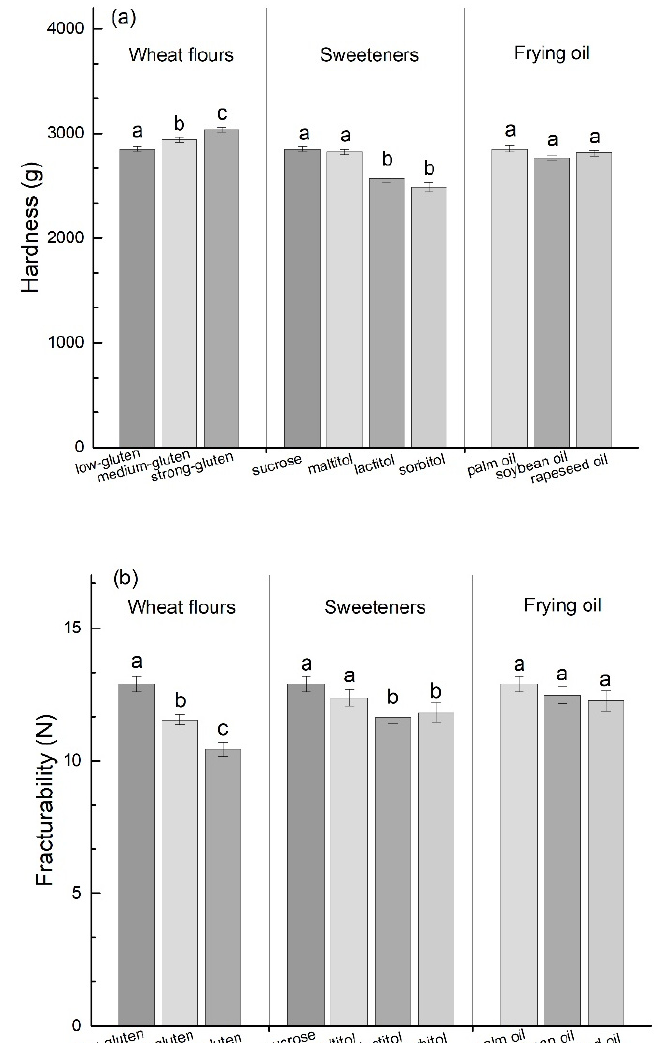
Figure 3. Effect of different ingredients (wheat flours, polyol sweeteners, and frying oil) on hard- ness ( a ) and fracturability ( b ) of fried dough twist (FDT). The different lowercase letters represent significant difference ( p < 0.05).